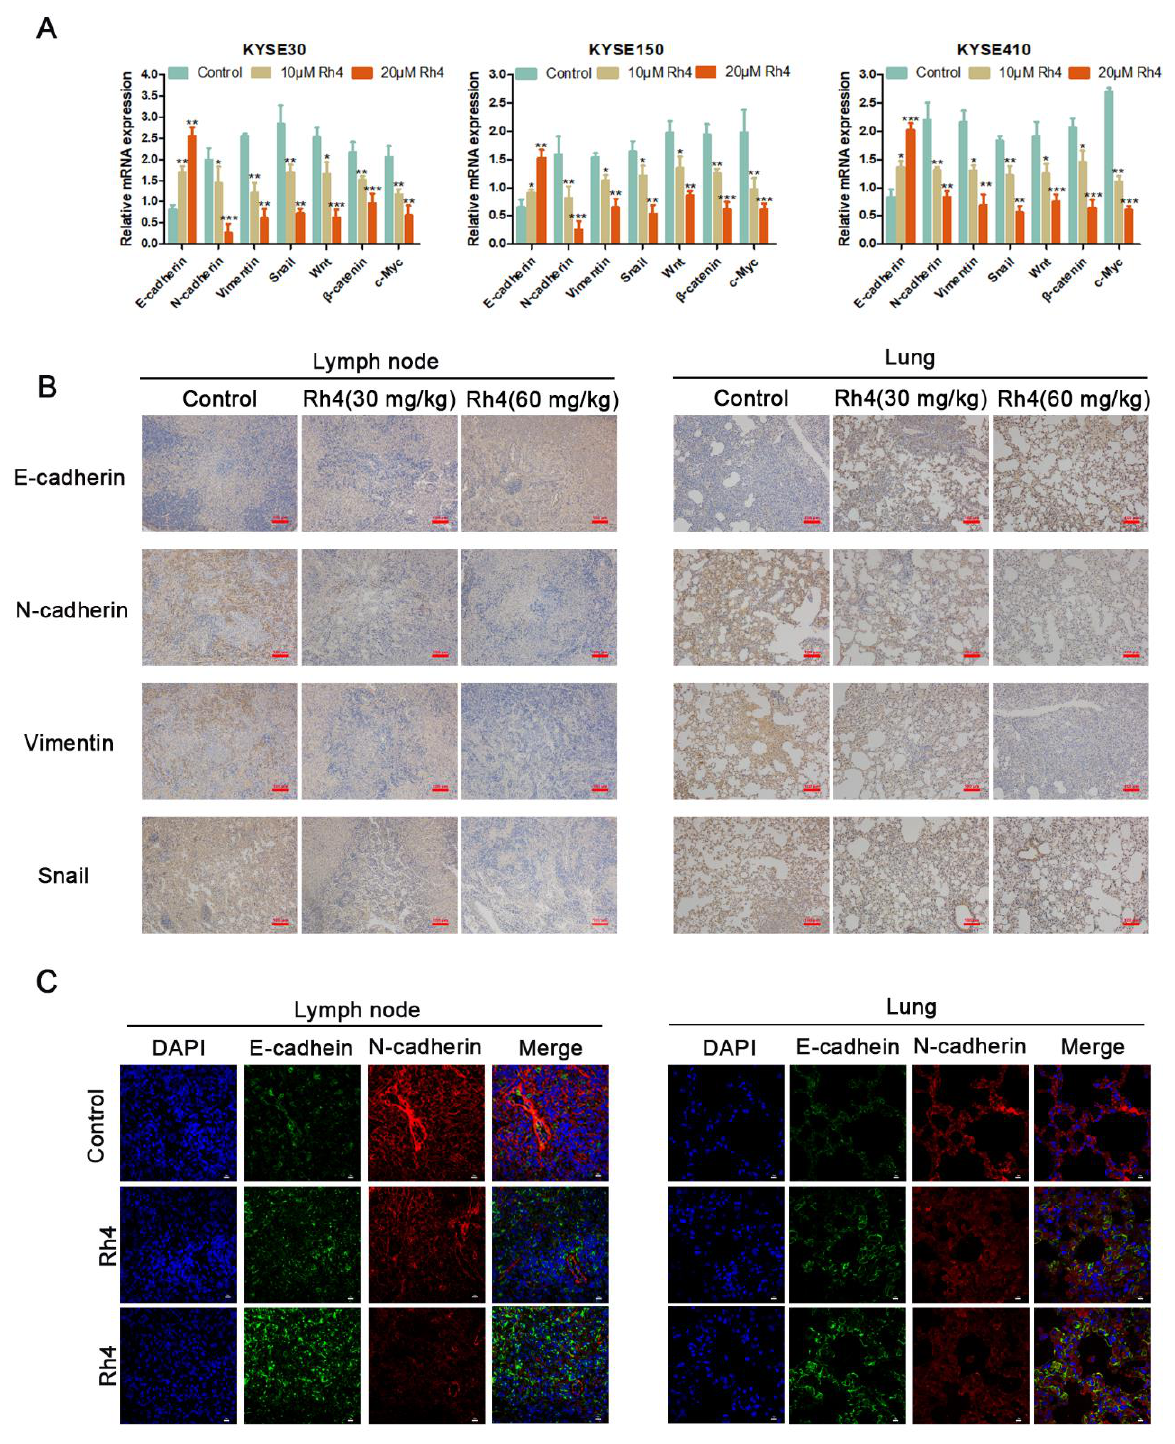
Figure 3. ( A ) Transcript of E-cadherin, N-cadherin, Vimentin, snail, wnt, β -catenin, and c-Myc after Rh4 treatment (10 and 20 µ M). ( B ) Immunohistochemical images of E-cadherin, N-cadherin, Vimentin, and snail. In lymph nodes and lungs. Scale bar = 100 µ m. ( C ) Immunofluorescence analysis showed that Rh4 promoted E-cadherin in lymph nodes and lungs and inhibited the expression of N-cadherin. Scale bar = 10 µ m. All data are presented as mean ± SD, * p < 0.05, ** p < 0.01, *** and p <